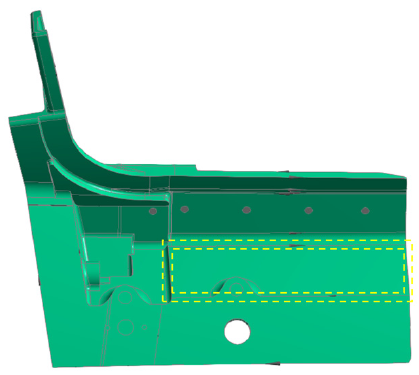
Figure 17. Outer edge of the bearing area.